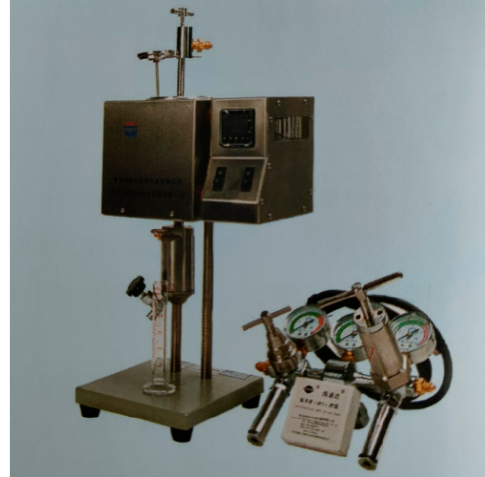
Figure 1. High temperature and pressure fi ltration instrument.